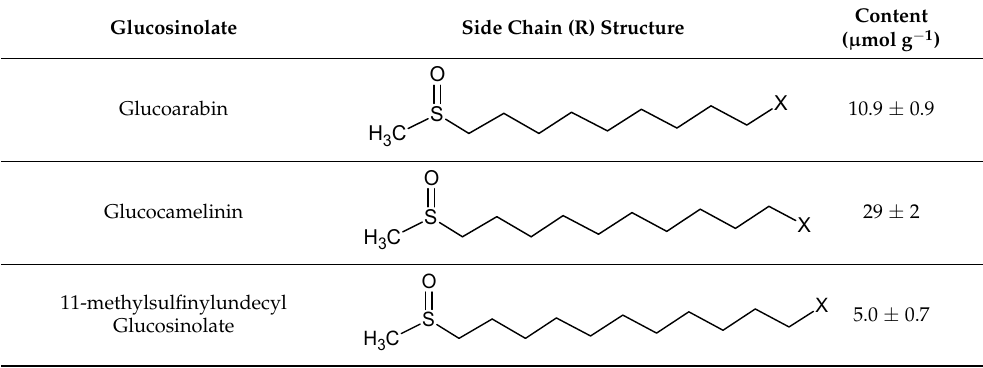
Table 1. Glucosinolates in Camelina sativa DSM. The contents are expressed in μ mol g − 1 of DSM. Means ± standard deviation (n = 3) are shown. Glucosinolate common variable side chain (R) chem- ical structure is also indicated, where X represents the GSL S-glucopyranosyl thiohydroximate moi- ety.